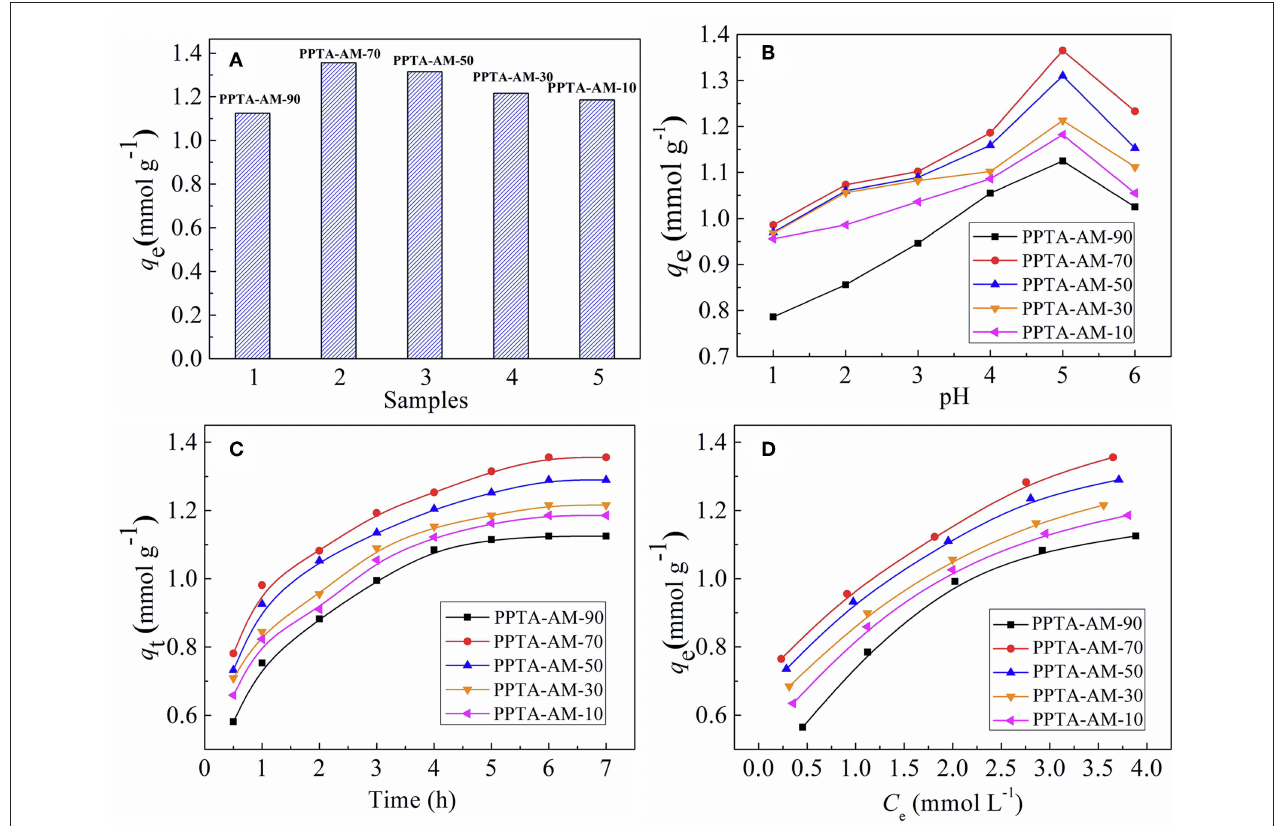
FIGURE 6 | Saturated adsorption capacities (A) , effect of pH (B) , adsorption kinetics (C) , and adsorption isotherms for Hg(II) onto PPTA-AM samples (D) .